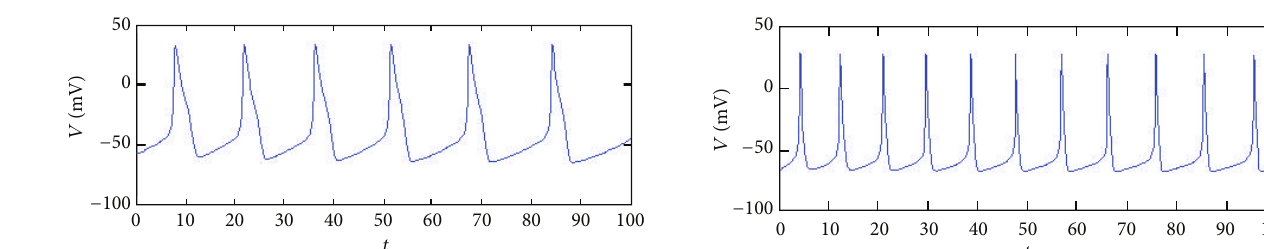
Figure 6: Membrane potential of a MC when 𝑔